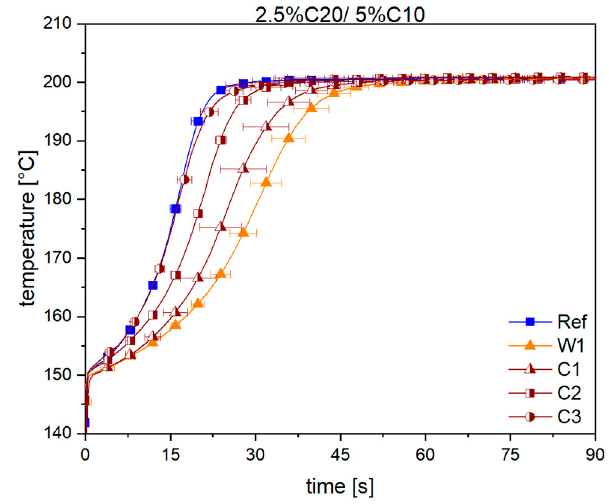
Figure 10. Compensation series of formulation 4 (2.5% C20, 5% C10). Polymerized at T pol = 150 °C and T mold = 150 °C.